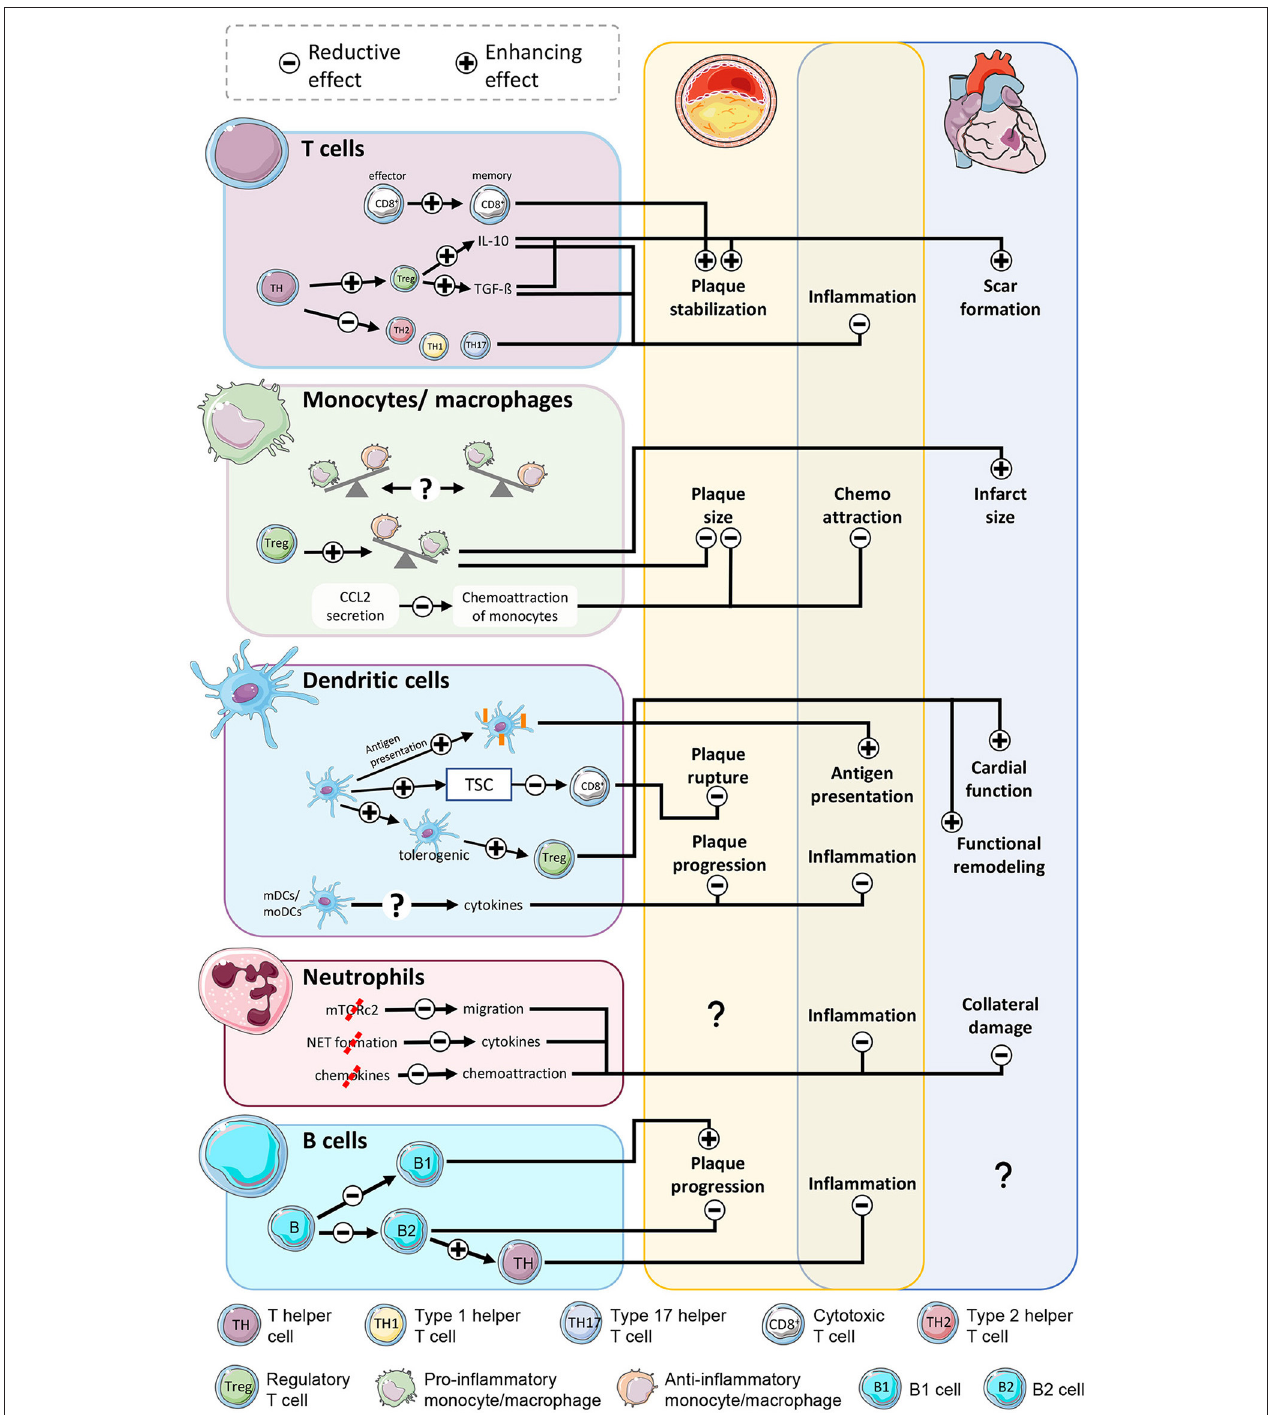
FIGURE 2 | mTOR-inhibition affects atherosclerosis and myocardial infarction by modulation of immune cells. Stabilization of plaques is accomplished by less active CD8+ T cells and a shift of T helper cells to an antiinflammatory phenotype. Reduced chemoattraction reduces the number of monocytes/macrophages at the inflammation site, ameliorating inflammatory activity in both diseases. The shift of monocytes into a reparative phenotype limits the scar size. Even though enhanced antigen presentation in dendritic cells increases inflammatory activity, the shift toward tolerogenic DCs and stimulation of Treg function soothes inflammation and benefits the outcome after AMI. Reduced neutrophil activity lessens the collateral damage to viable myocardium in the border zone. B cell subpopulations exert contrary effects on atherosclerosis with yet unclarified outcome.